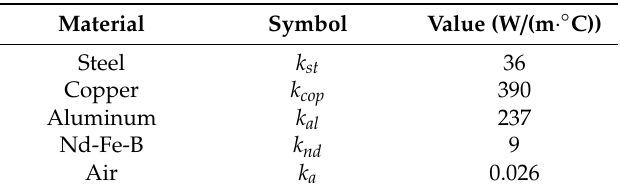
Table 2. Thermal Conductivity of the